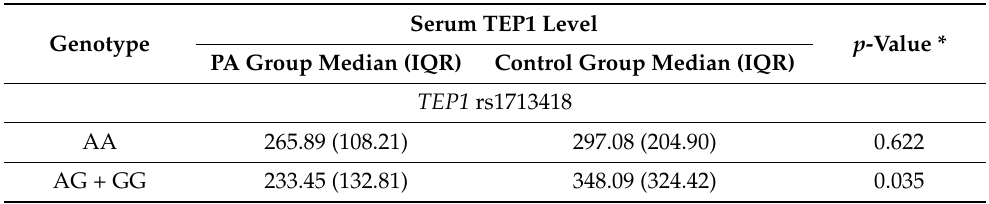
Table 12. Frequencies of genotypes and serum TEP1